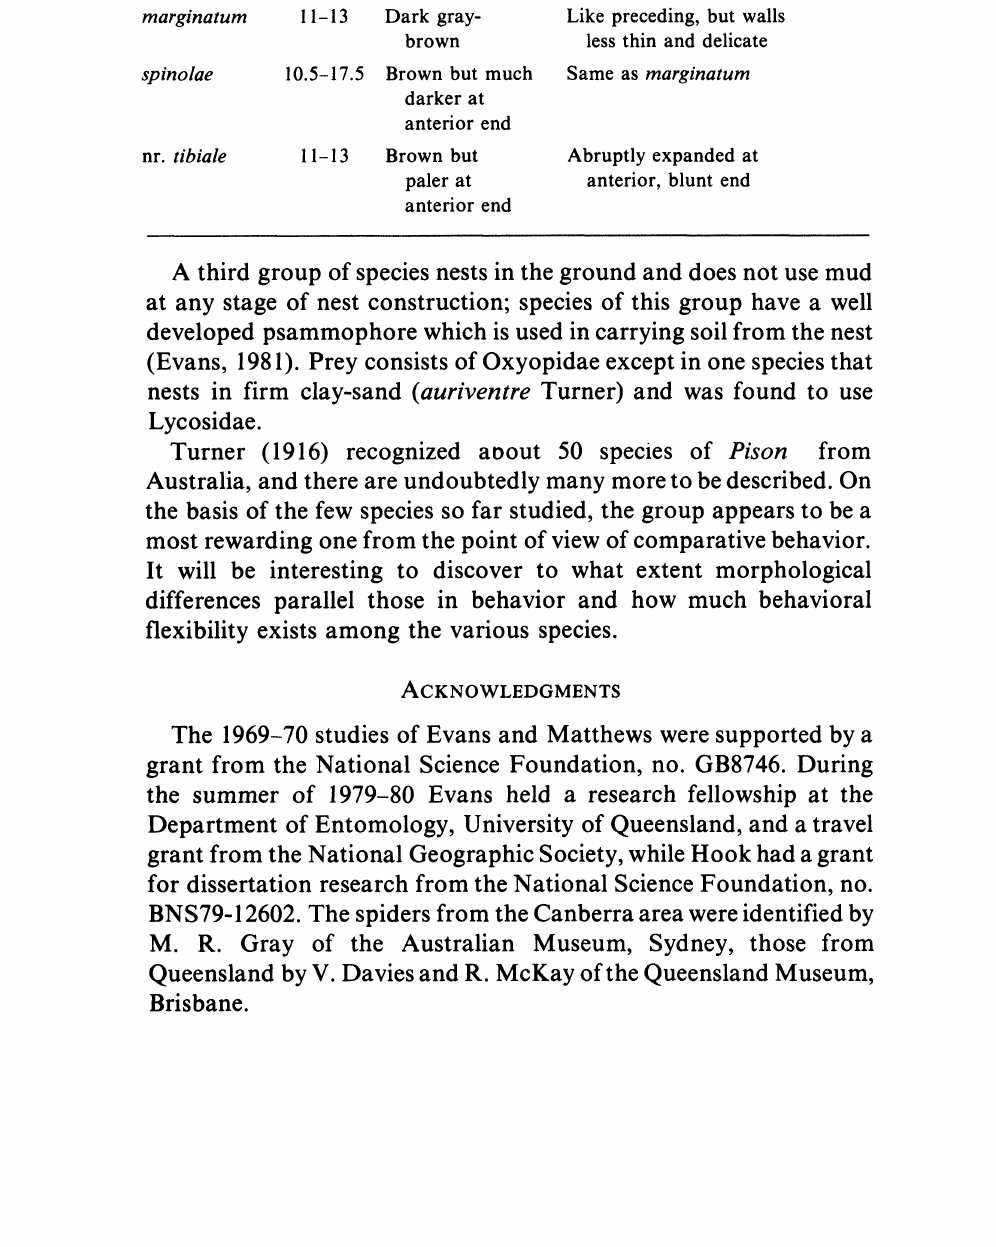
Table I. Major features of cocoons of four species of Pison. Species